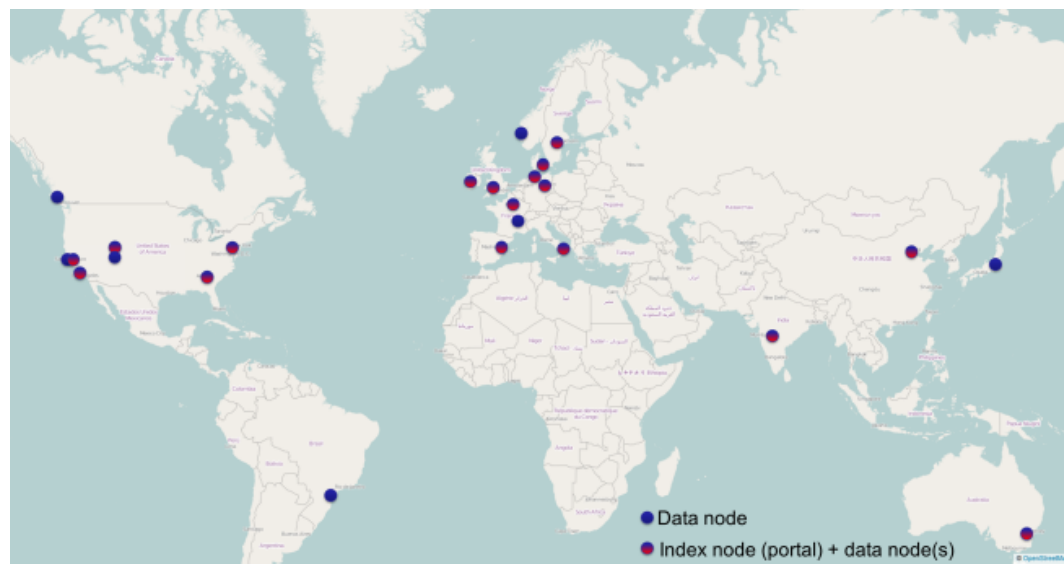
Figure 1. Sites participating in the Earth System Grid Federation in May 2017. Figure courtesy of the IS-ENES data